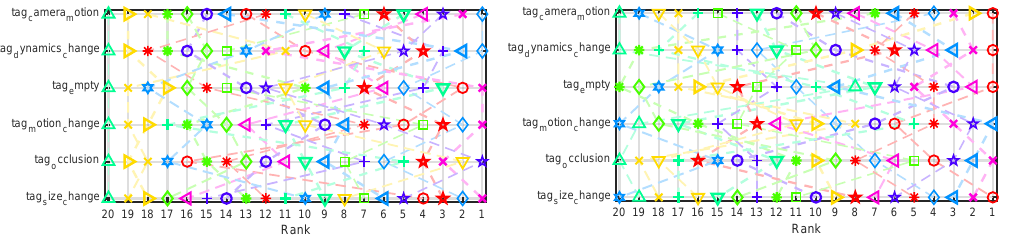
Figure 9. Accuracy ranking and robustness ranking of 20 trackers on six different attributes (see Figure 6 for